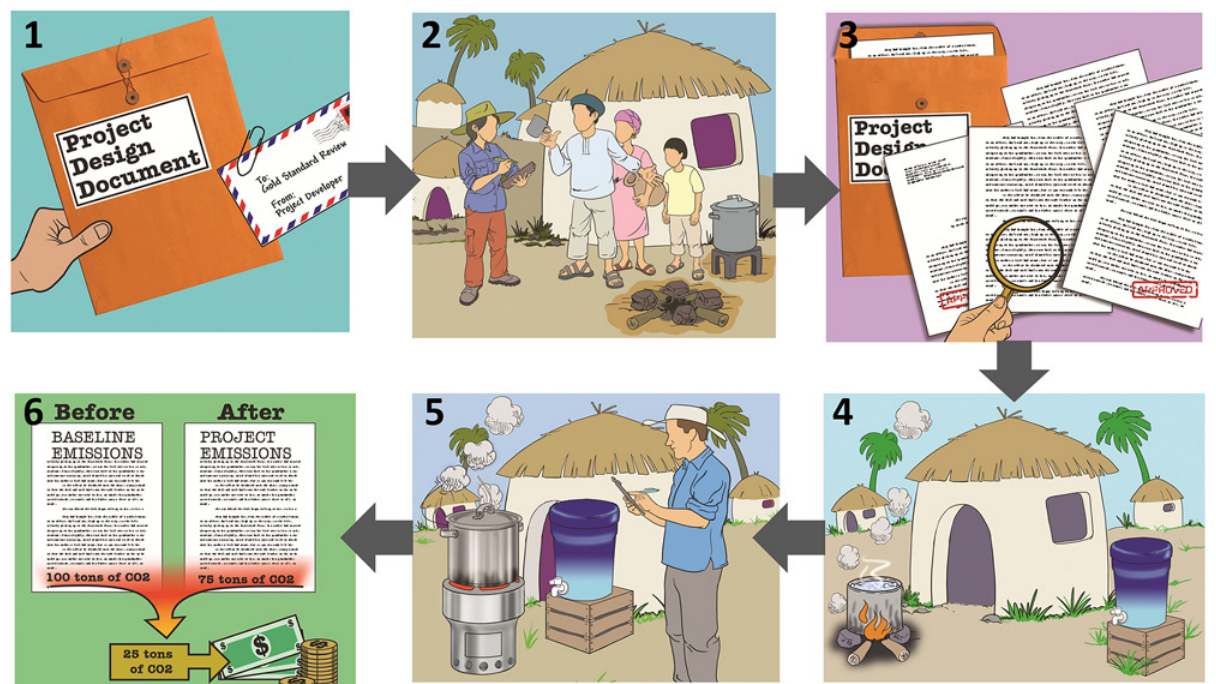
Fig 1. Description of steps for projects to obtain carbon credits for a household water treatment project. (A) Step 1: The project has to submit a Project Design Document (PDD) to Gold Standard for review (B) Step 2: Within the PDD the project developer must provide detail on the project location and baseline characteristics of end-users of the HWT. The characteristics of technology users include the baseline technology in use (type of stove/fuel) and user practices (time spent cooking/boiling water). (C) Step 3: A third party entity conducts stakeholder interviews and confirms that if the project were to move forward as proposed planned emissions reductions would be achieved. (D) Step 4: The project technology is installed and ready for use. (E) Step 5: A third party designated operational entity (DOE) periodically collects monitoring data on indicators of fuel and filter user throughout the stated life of the project. These indicators are used to calculate project level emissions. (F) Step 6: The project level emissions are subtracted from the baseline emissions and carbon credits are issued based on the difference.